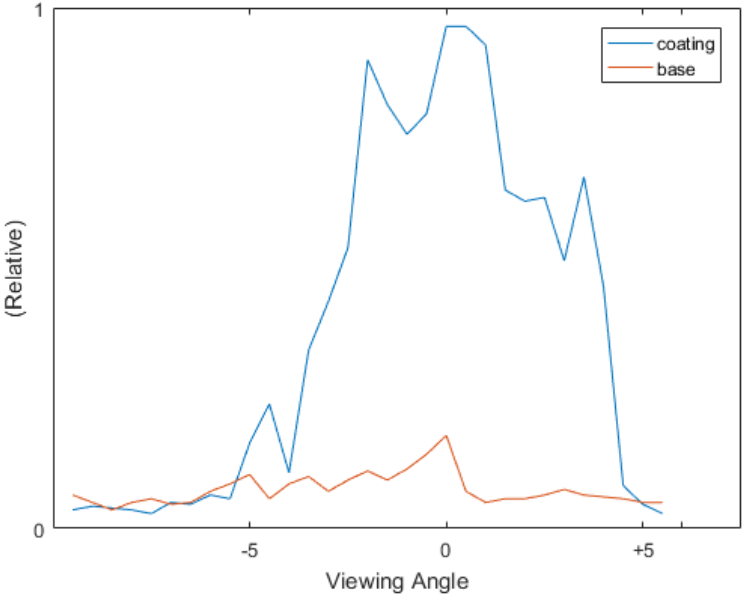
Figure 9. The BRDF-distribution measurement result of the coating layers and the rusted base layer of the marine antifoul coating sample.